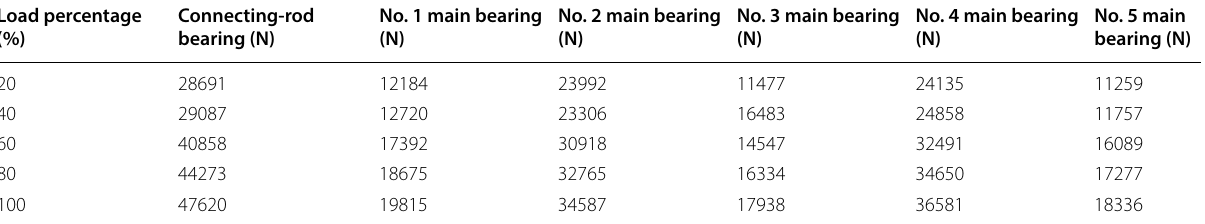
Table 3 Maximum loads of connecting‑rod bearing and all main bearings at 2200 r/min and different load percentage Load percentage